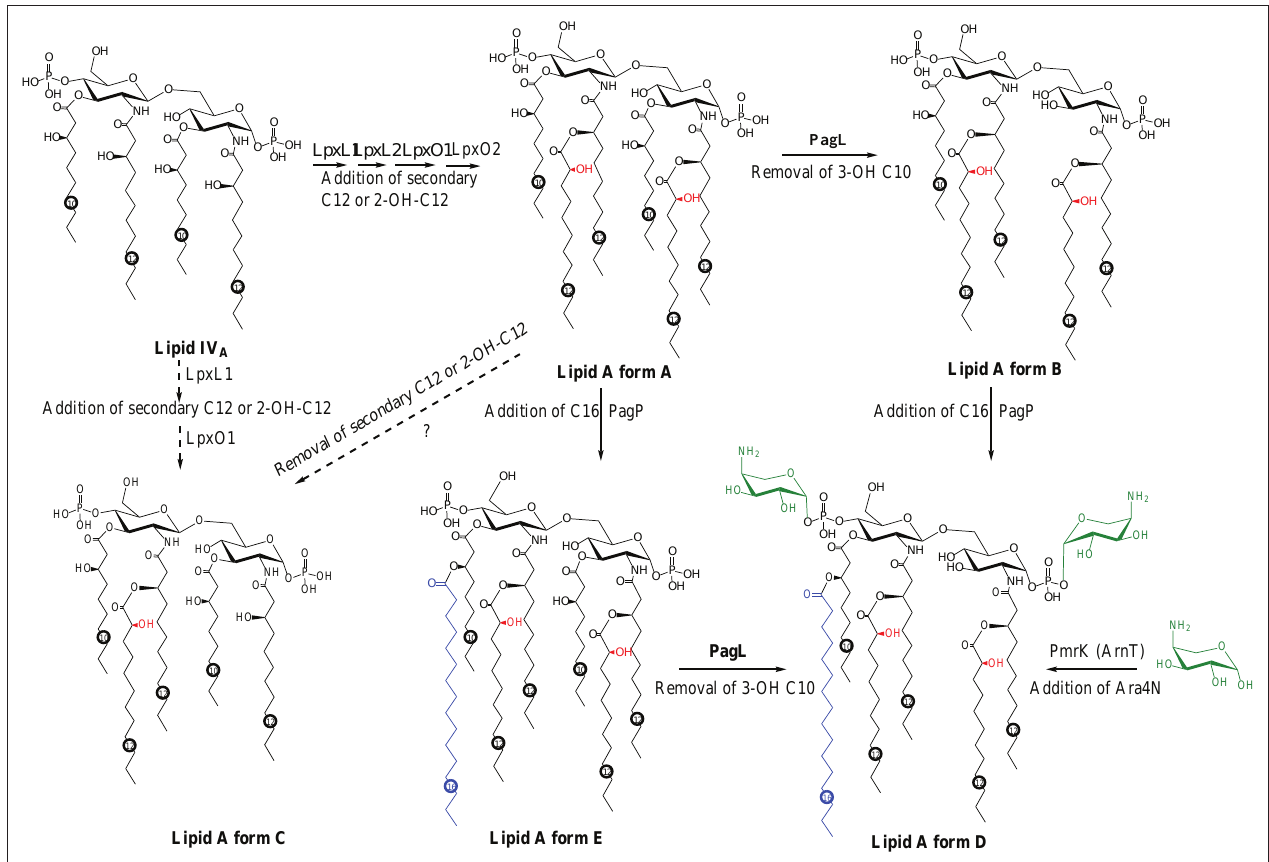
FIgure 5 | Different lipid A forms of P. aeruginosa and the proposed biosynthesis and modification